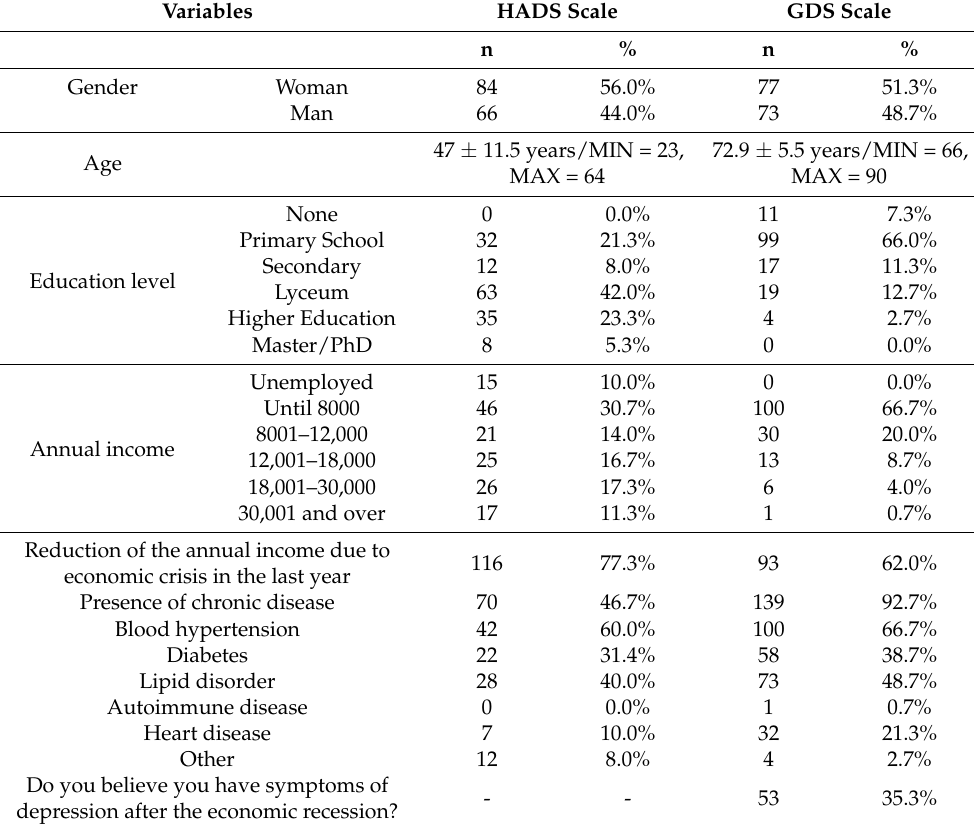
Table 1. Demographic and clinical characteristics of the sample that completed the Hospital